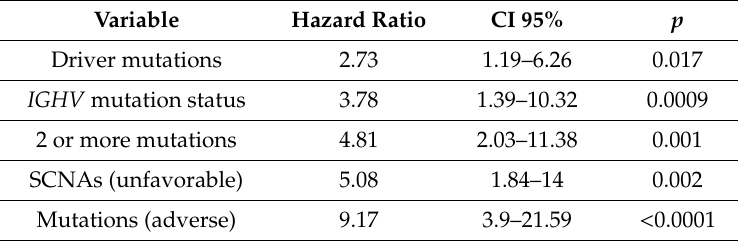
Table 2. Univariate analysis for progression-free